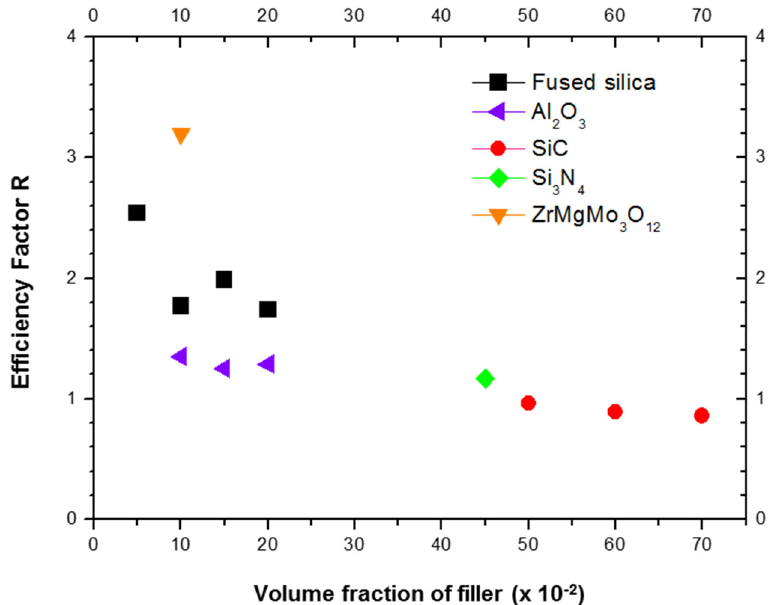
Figure 8. Efficiency factors of ceramic fillers on CTE reduction versus ceramic volume fractions. Efficiency factors of fused silica fillers within Alumix-231 matrix, sintered at 565 ◦ C, were plotted. Efficiency factors for ZrMgMo 3 O 12 , SiC, Al 2 O 3 and Si 3 N 4 are available from literature [36,39–41].